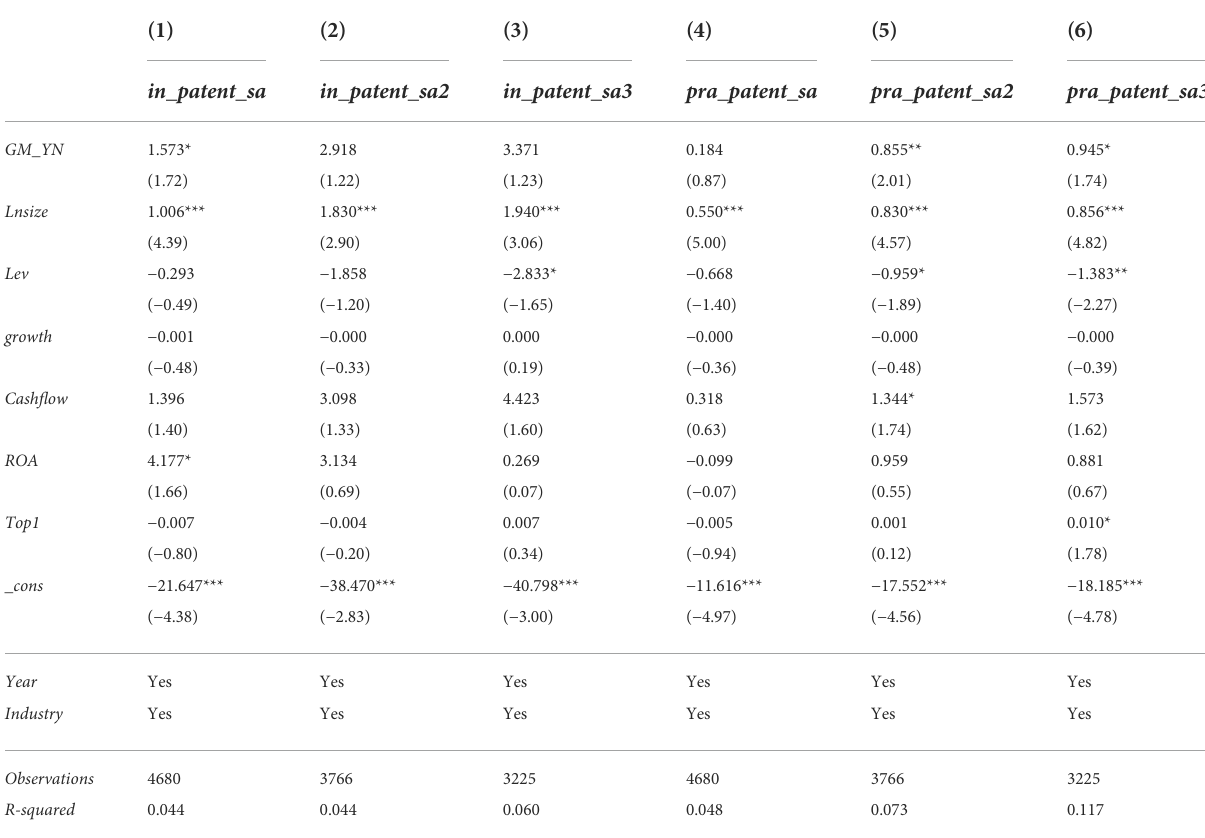
TABLE 12 Green M&A and green